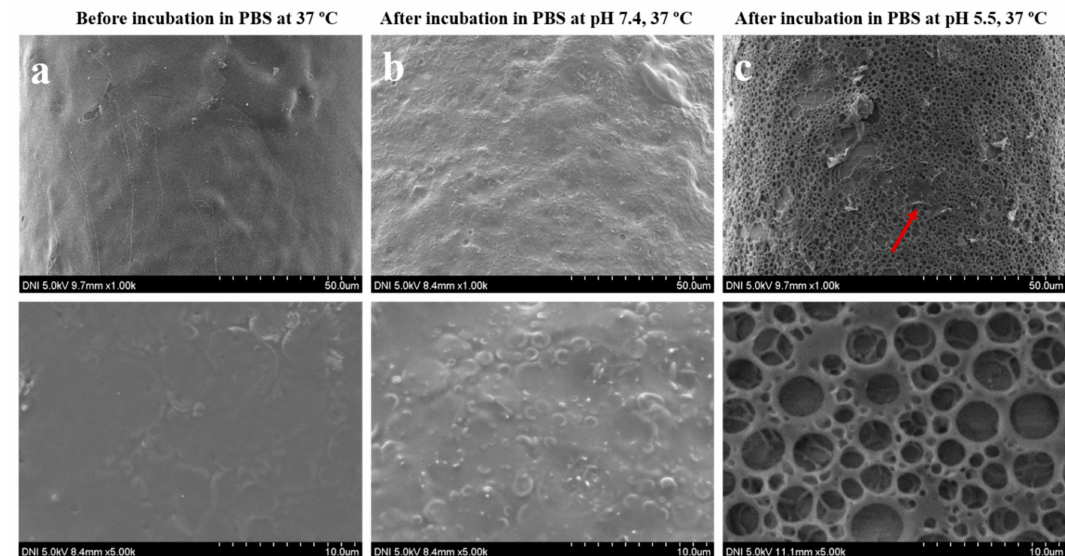
Figure 4. SEM images obtained at di ff erent magnifications of pH-responsive porous coated MNs: ( a ) before incubation; ( b ) after incubation at pH 7.4; ( c ) after incubation at pH 5.5 in phosphate-bu ff ered saline (PBS) at 37 ◦ C. The morphology of MNs before and after incubation at pH 7.4 was the same. The pores were unexposed, and the thin poly(lactic- co -glycolic acid) (PLGA) membrane stayed intact, whereas the pores of MNs incubated in PBS at pH 5.5 were open and the membrane was ruptured. The arrow indicates some traces of the remaining thin PLGA on the surface of the